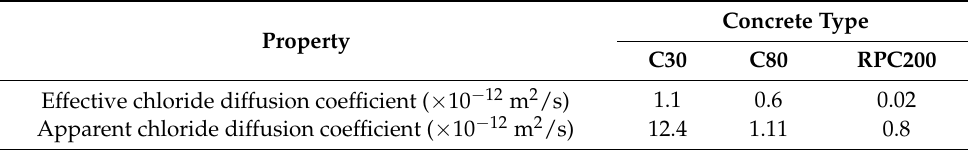
Table 5. Chloride diffusion coefficients, effective and apparent, of the reactive powder concrete, C30, and C80.